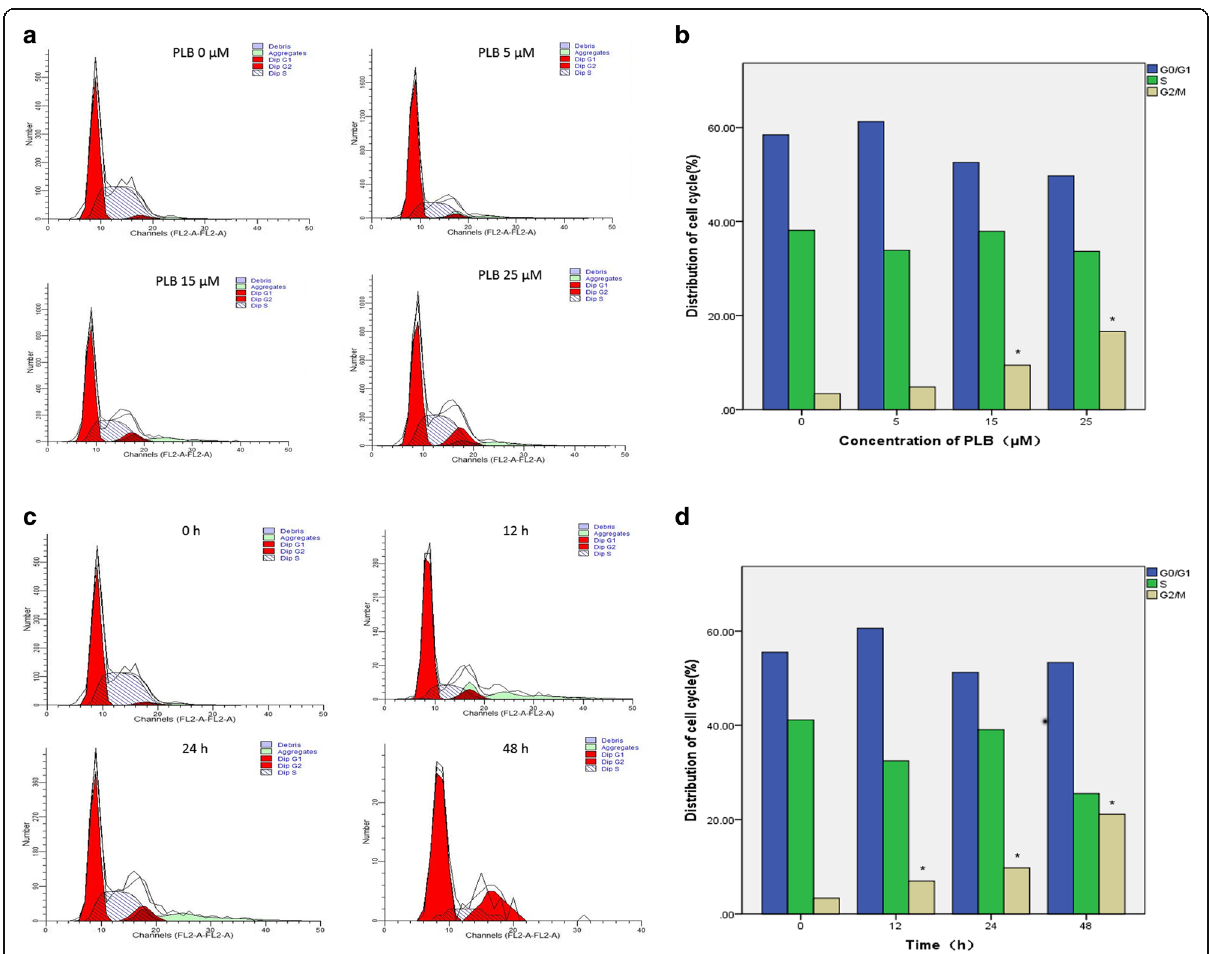
Fig. 3 Plumbagin induces G2/M in ARPE cells. The population of cells was analyzed by flow cytometry. Data represented the mean ± SD of three individual experiments. (* P < 0.05 by one-way ANOVA.). Notes: ( a ) Flow cytometric histograms show the cell cycle distribution when the cells were treated with PLB at 0, 5, 15 and 25 μ M for 24 h; ( b ) Bar graphs show the cell cycle distribution (G0/G1 、 S and G2/M phase) when the cells were treated with PLB at 0, 5, 15, and 25 μ M for 24 h. c Flow cytometric histograms show the cell cycle distribution when the cells were treated with 15 μ M PLB at 0, 12, 24, and 48 h; ( d ) Bar graphs show the cell cycle distribution (G0/G1 、 S and G2/M phase) when the cells were treated with 15 μ M PLB at 0, 12, 24, and 48